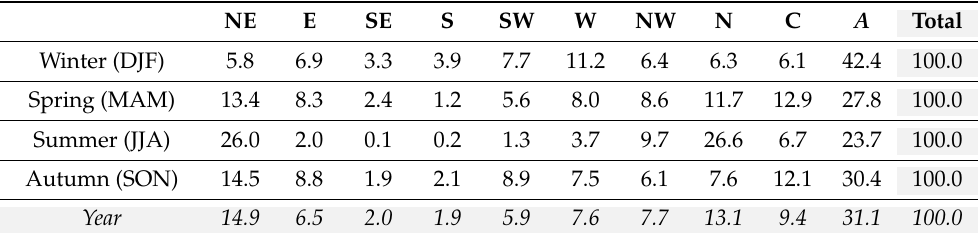
Table 2. Seasonal (and annual, light gray row) relative frequencies (in %) of each CWT during